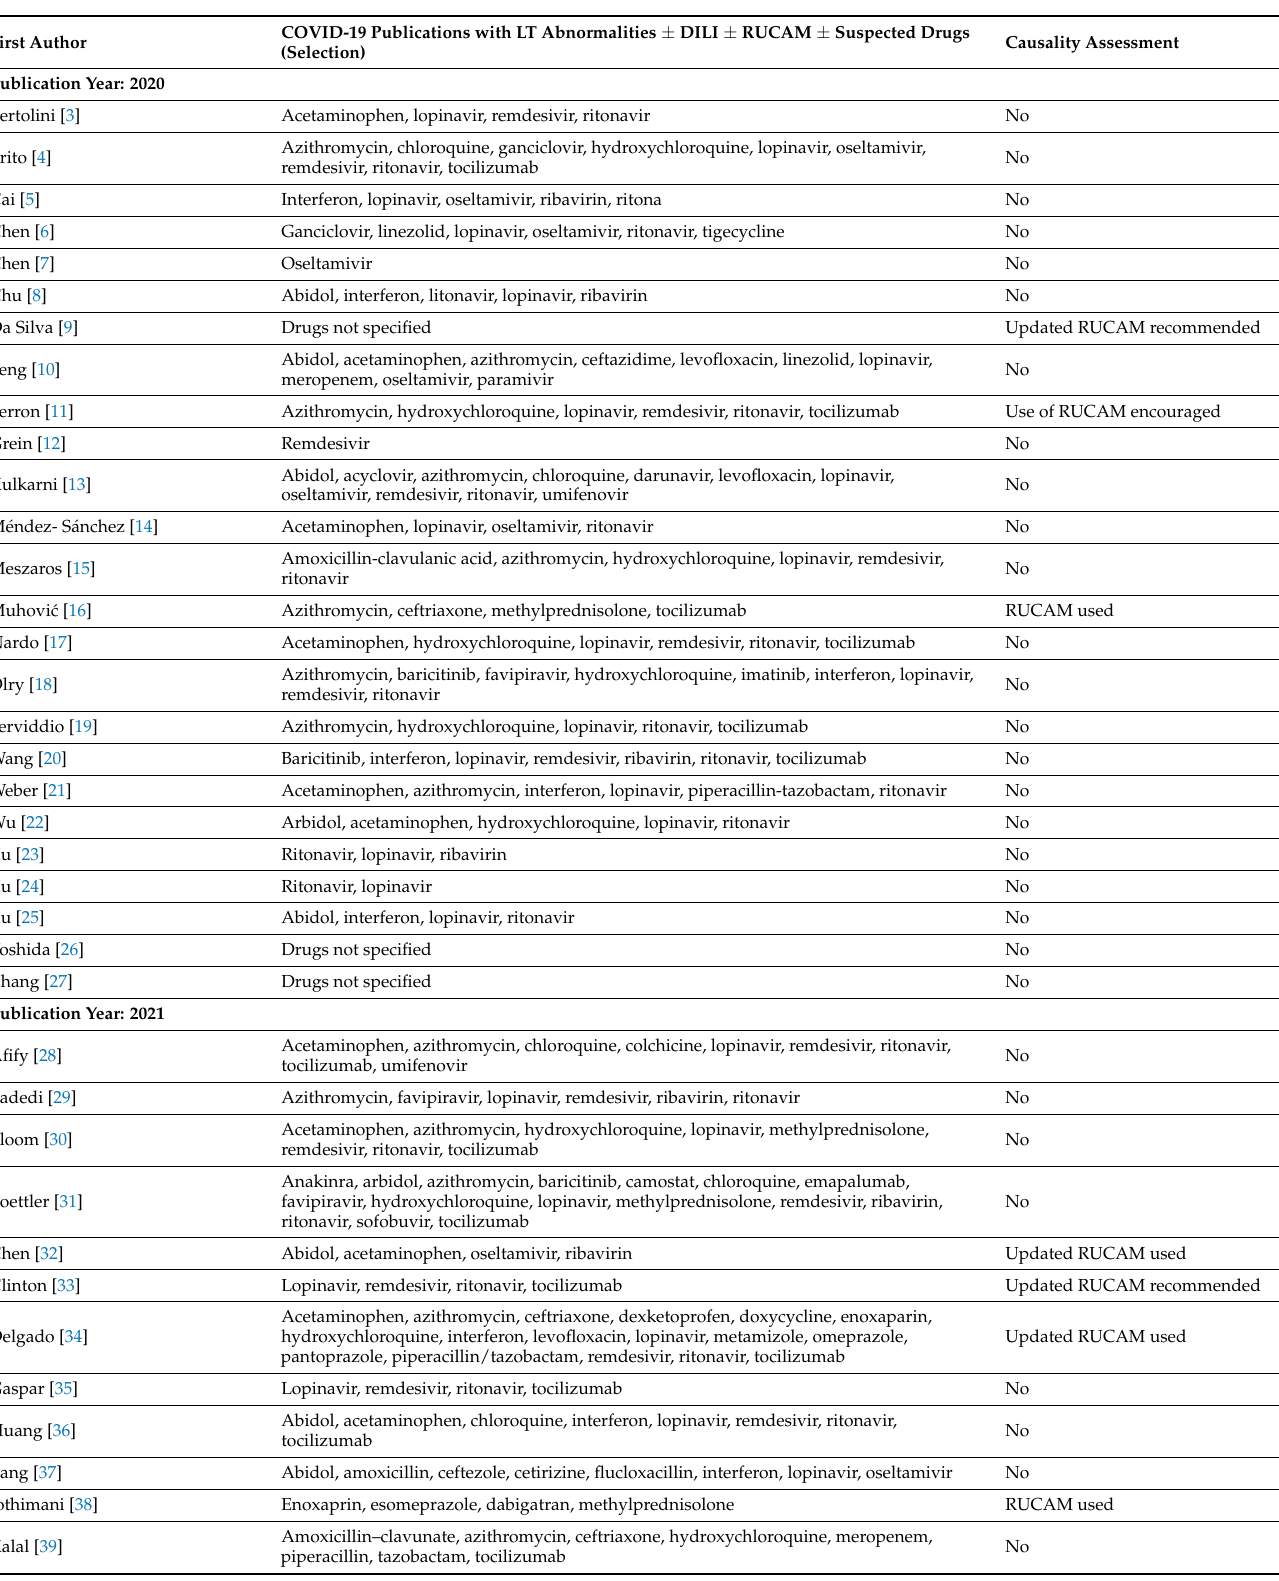
Table 1. COVID-19 reports published in2020 and 2021 with liver test abnormalities ± DILI ± RUCAM ± individual